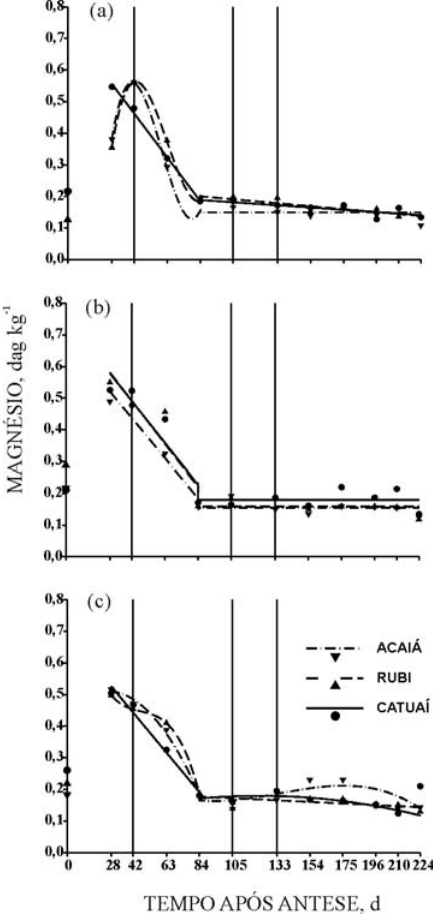
Figura 3. Concentração de magnésio em frutos de cafeeiro durante o período reprodutivo, nos níveis baixo (a), adequado (b) e alto (c) de adubação. As linhas verticais delimitam os estádios de desenvolvimento do fruto de chumbinho, expansão rápida, crescimento suspenso e granação-maturação. Quadro 3. Produtividade de café beneficiado de três variedades de Coffea arabica submetidas a três níveis de